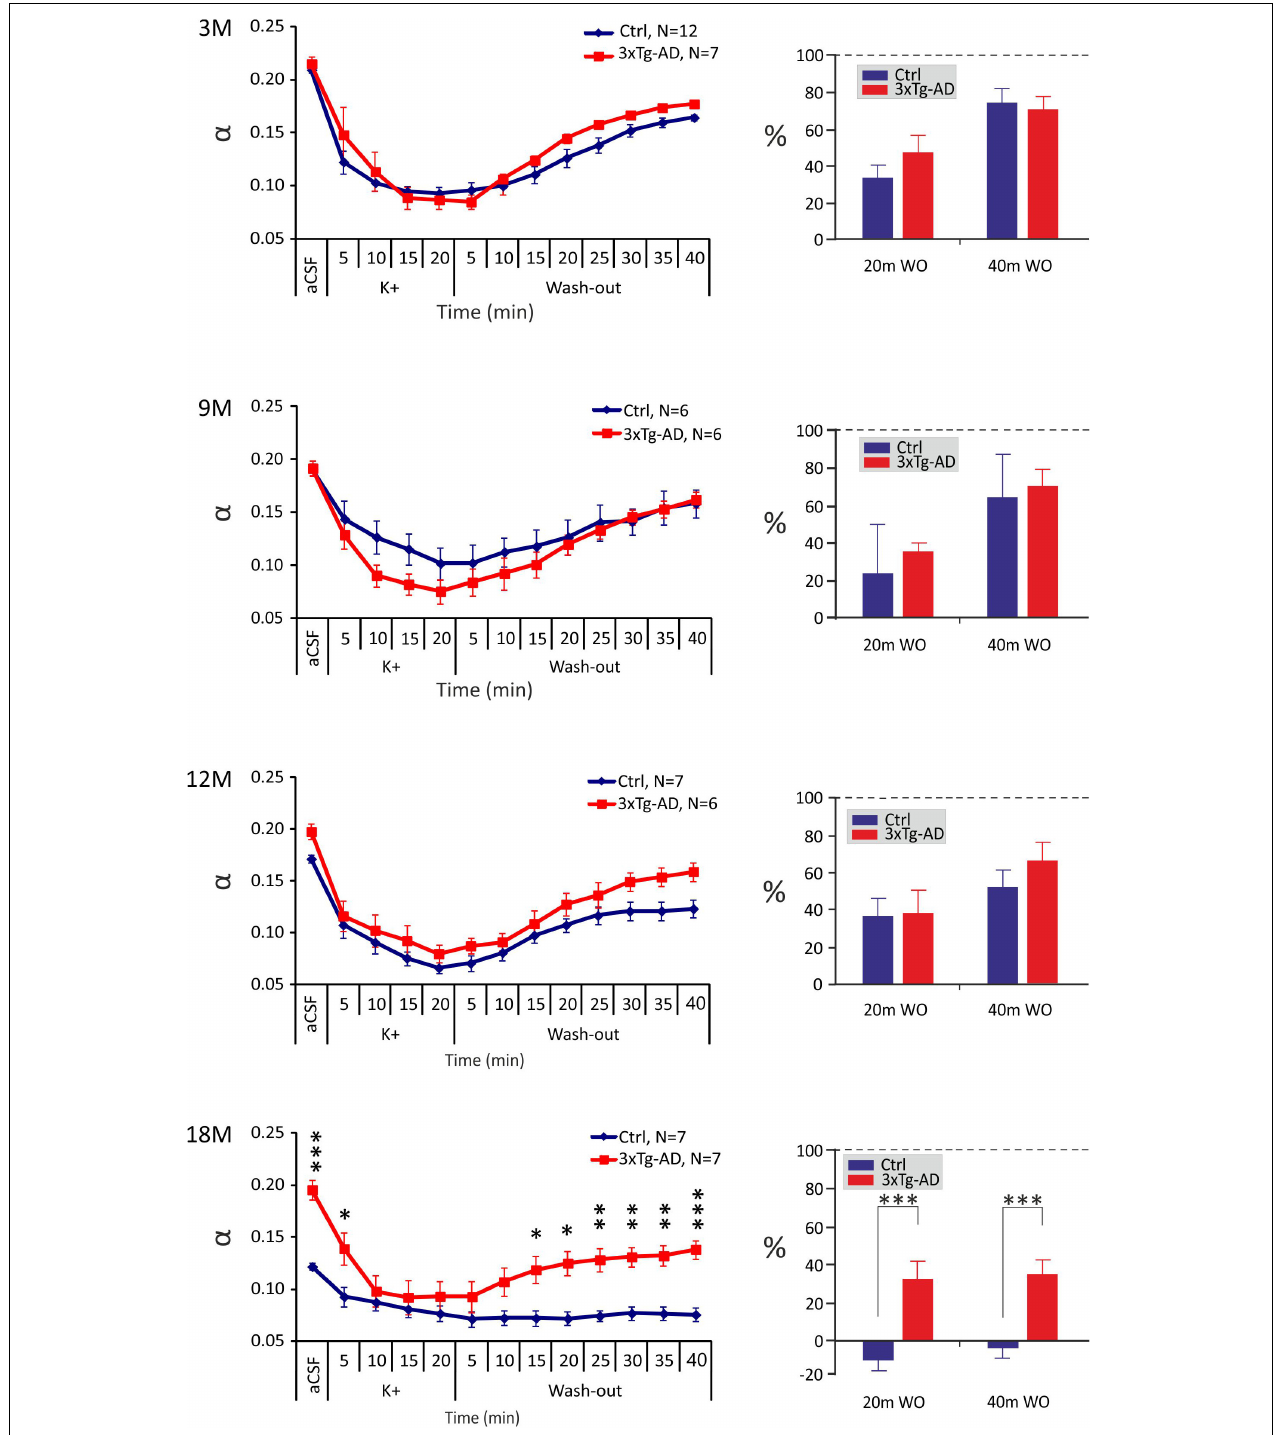
FIGURE 4 | Age-dependent changes of the absolute values of the ECS diffusion parameters in control (Crtl) and 3xTg-AD mice evoked by severe hyperkalemia (50 mM K + ). The left side: Time course of the volume fraction ( α ) changes during a 20-min application of aCSF K + and a 40-min washout in 3-, 9-, 12- and 18M-old control animals and age-matched 3xTg-AD mice. The right side: Volume fraction recovery during washout at 20 min intervals is expressed as changes in the values reached in the 20th min of application, set as 0%. Data are presented as mean ± SEM. Statistical significance was determined by two-way ANOVA test with Tukey’s post hoc test. Asterisks indicate significant differences between Ctrl and 3xTg-AD mice ( ∗ p < 0.05, ∗∗ p < 0.01, ∗∗∗ p < 0.001). Ctrl, control mice; 3xTg-AD, triple transgenic model of AD; aCSF, artificial cerebrospinal fluid, K+, artificial cerebrospinal fluid with elevated K+ concentration; WO, wash-out; 3M, 9M, 12M, 18M, 3-, 9-, 12-, 18-month-old animals; N, number of